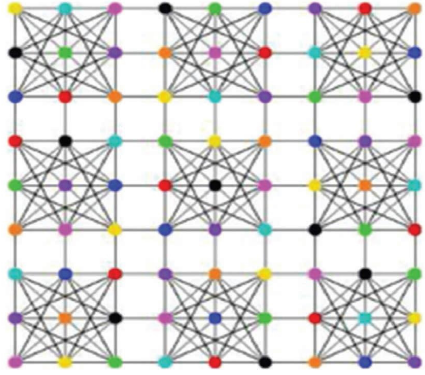
Figure 1: Te Sudoku nanosheet SK Table 1: Edge partition of Sudoku nanosheet SK